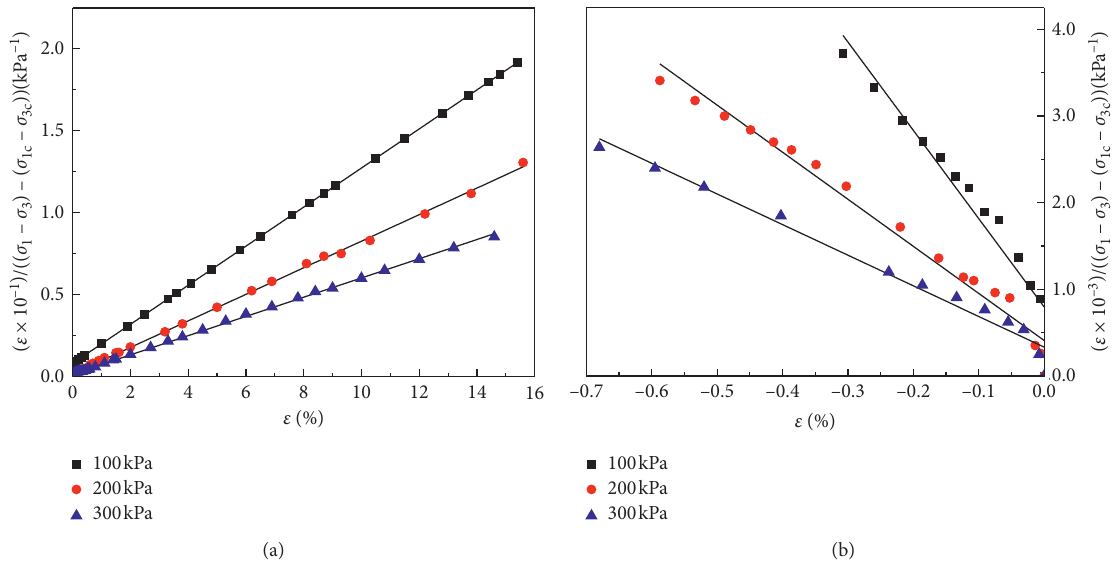
Figure 6: Hyperbolic functions of the deviator stress-strain relationships. (a) Stress path UU0.0. (b) Stress path UU2.0. Table 3: Initial tangent modulus of soft soil under different stress paths (100kPa). Stress